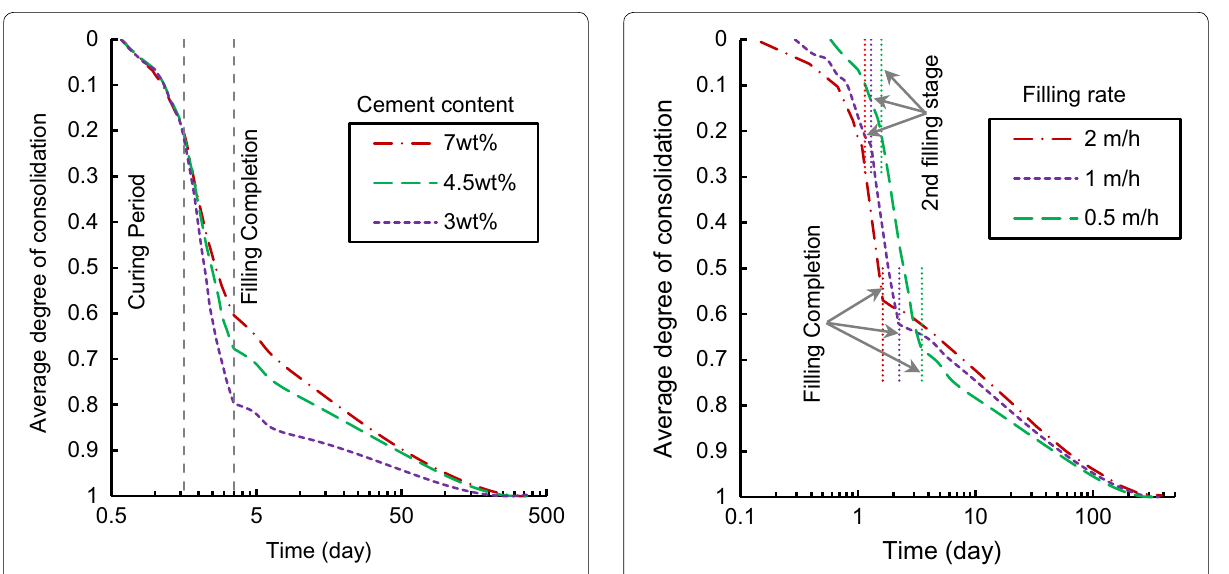
during the post-filling stage. Therefore, this study clearly demonstrates the combined effect of harden- ing induced by binder hydration, overburden stress and chemical shrinkage on the consolidation behavior of CPB.